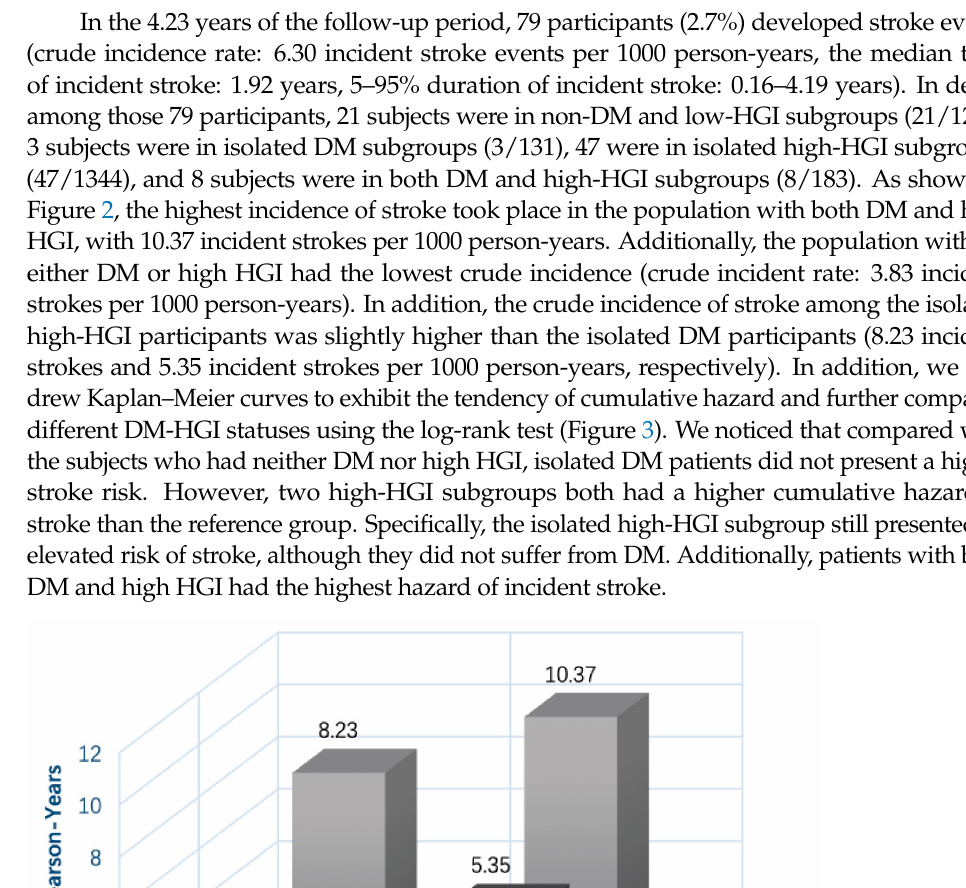
Figure 3. Kaplan–Meier curves for cumulative hazard of incident stroke events stratified by DM- HGI system. Kaplan–Meier curves exhibited the tendency of cumulative hazard, and we further compared different DM-HGI statuses using the log-rank test. Compared with the subjects who had neither DM nor high HGI (blue curve), isolated DM patients did not present a higher incident stroke risk (red curve). However, two high-HGI subgroups both had higher cumulative hazards of stroke than reference. Especially, the isolated high-HGI subgroup presented an elevated risk of stroke, alt- hough the subgroup population did not suffer from DM (green curve). Moreover, the patients with both DM and high HGI had the highest hazard of stroke (orange curve). Abbreviations: HGI,